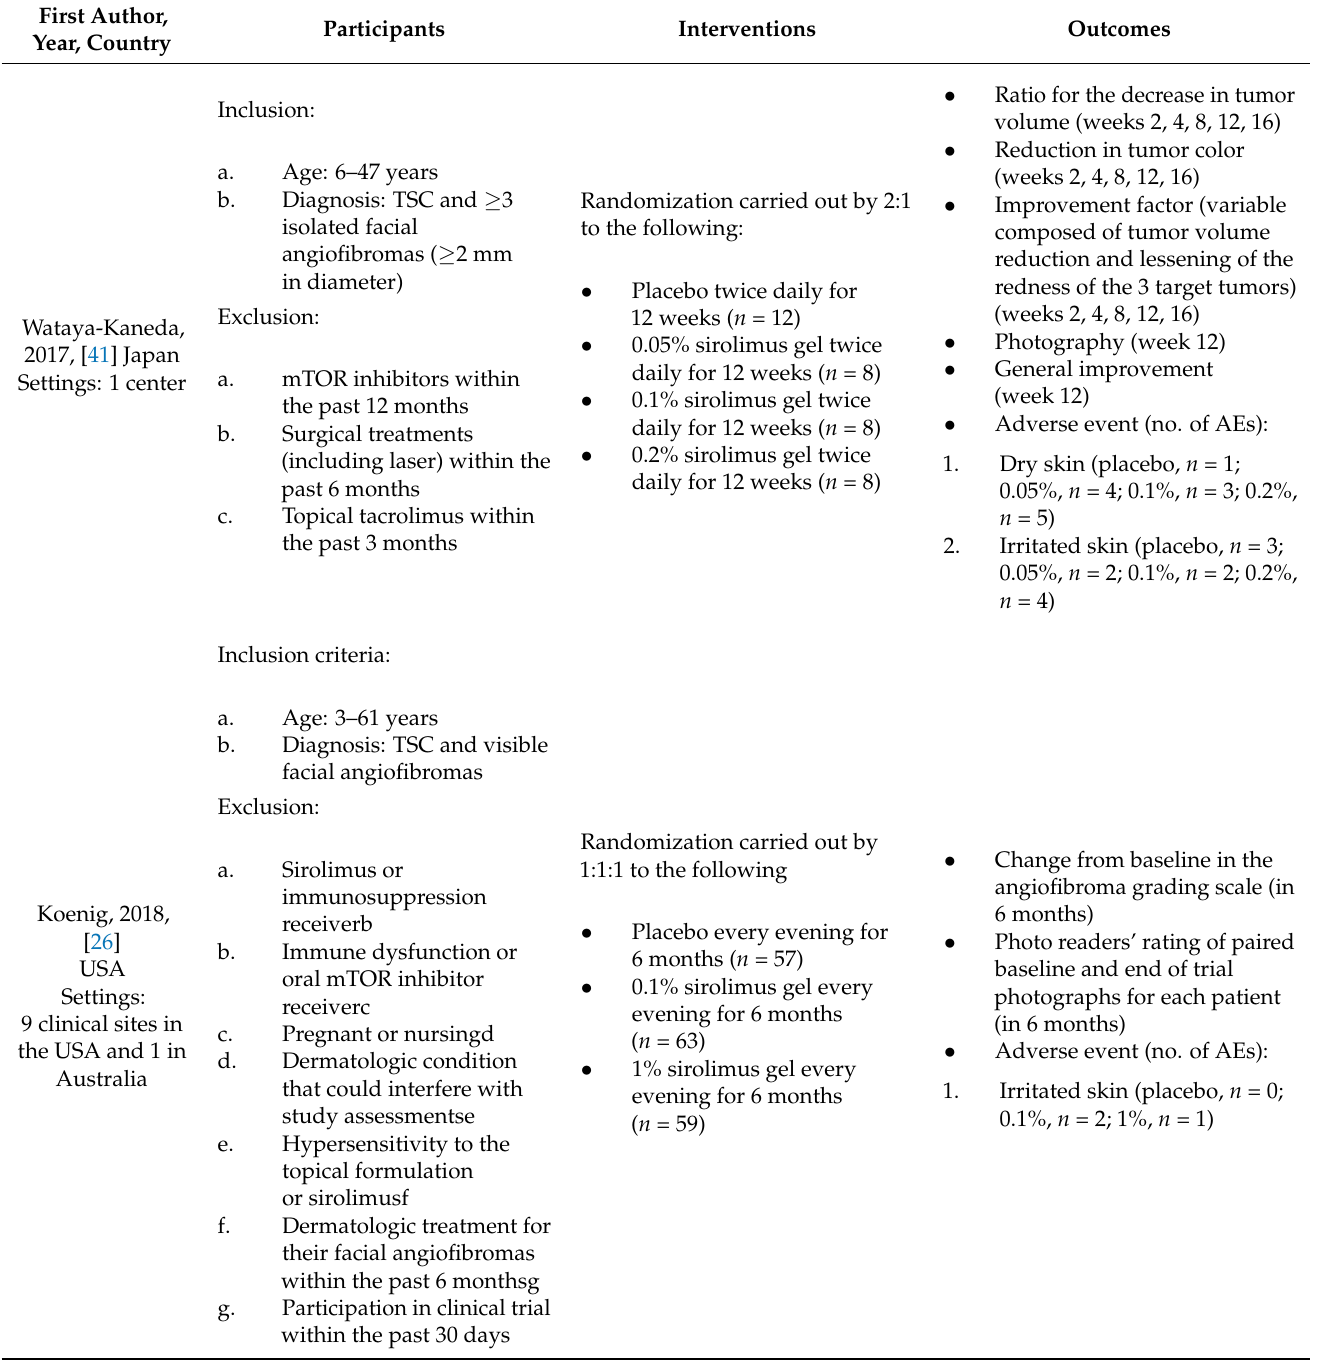
Table 1. Characteristics and included